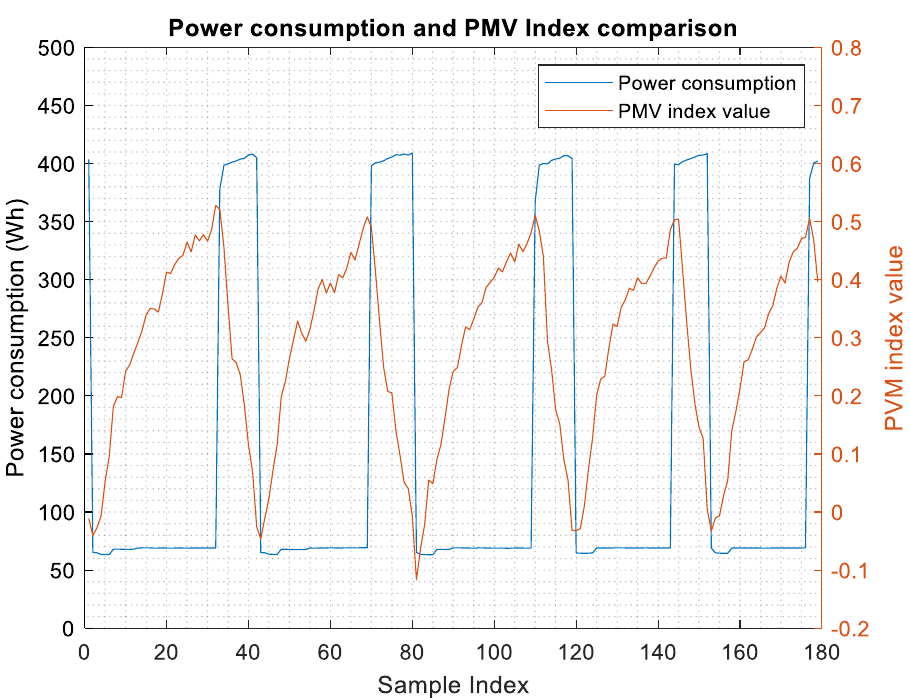
Figure 15. Power consumption and PMV index values comparison .